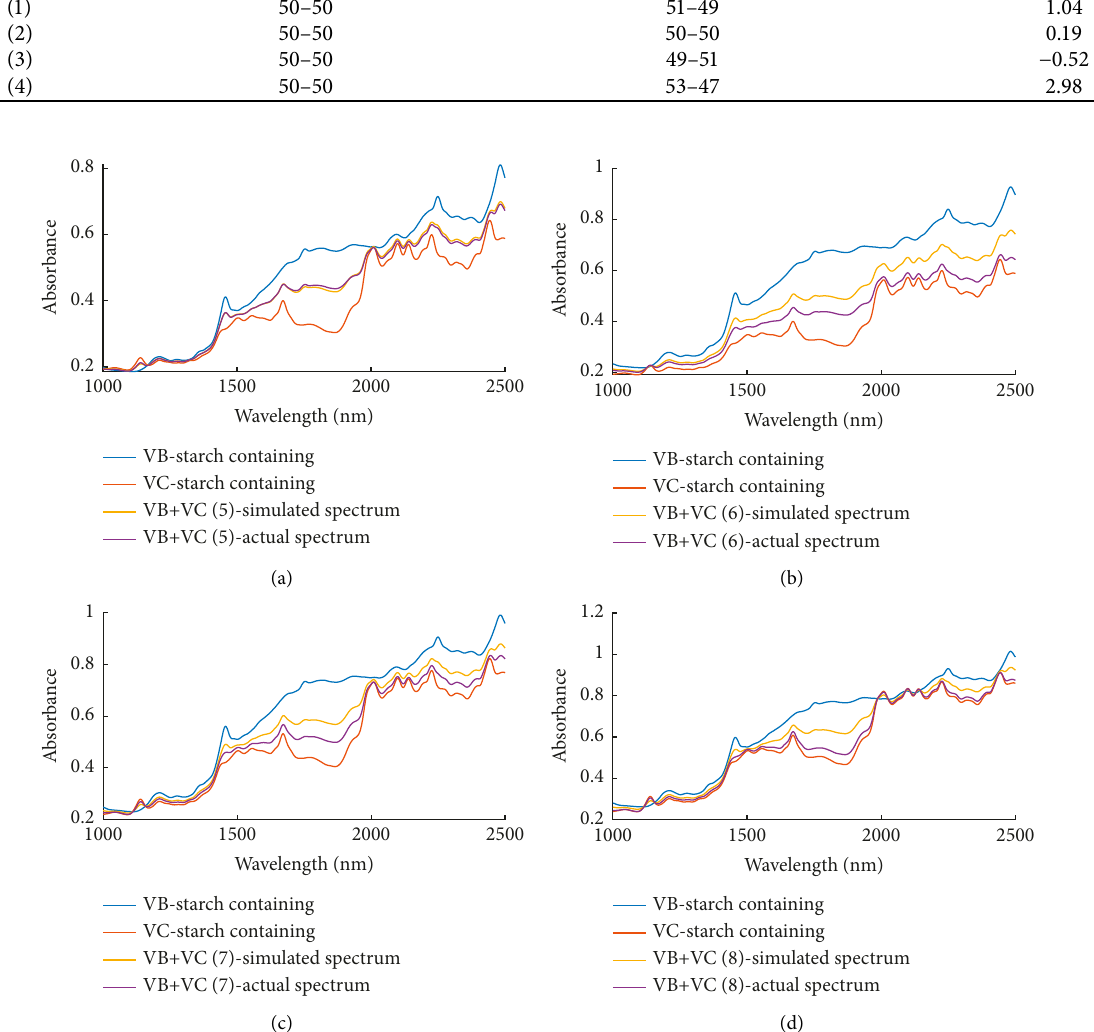
Figure 3: Single sample spectra, the actual mixed spectra, and the corresponding simulated mixed spectra of (a) sample VB +VC (5) ( − < Table 5: RD, F -value, and T -value of actual mixed spectra and simulated mixed spectra of the vitamin samples VB+VC (5) VB+VC (8). F